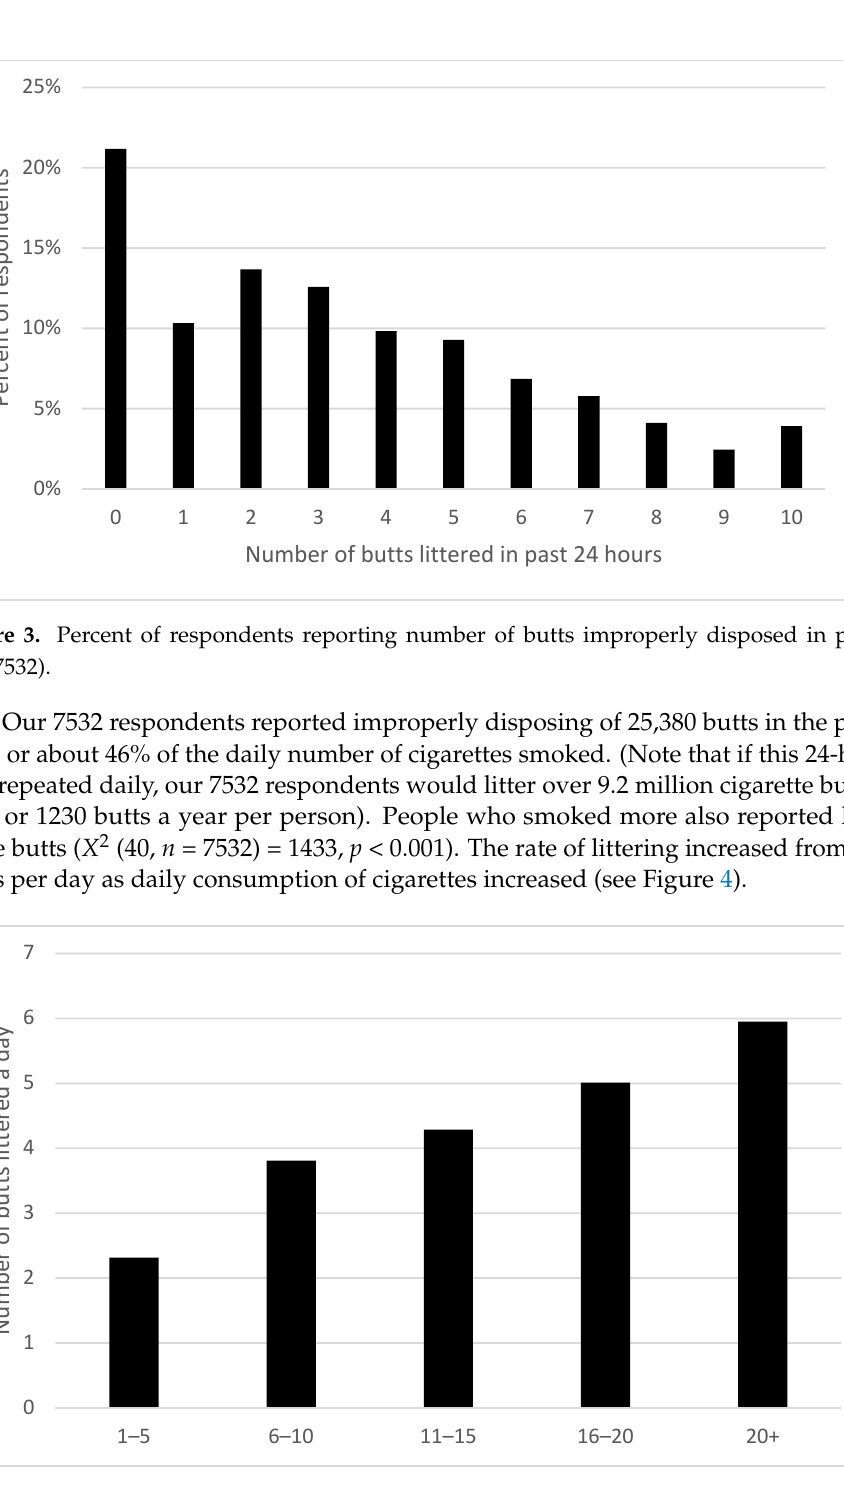
Figure 4. Average number of butts littered per person in past 24 h by number of cigarettes smoked a day ( n = 7532). Women littered fewer butts than did men ( X 2 (10, n = 7463) = 277, p < 0.001). The effect was found in all the smoking-rate groups (see Figure 5).